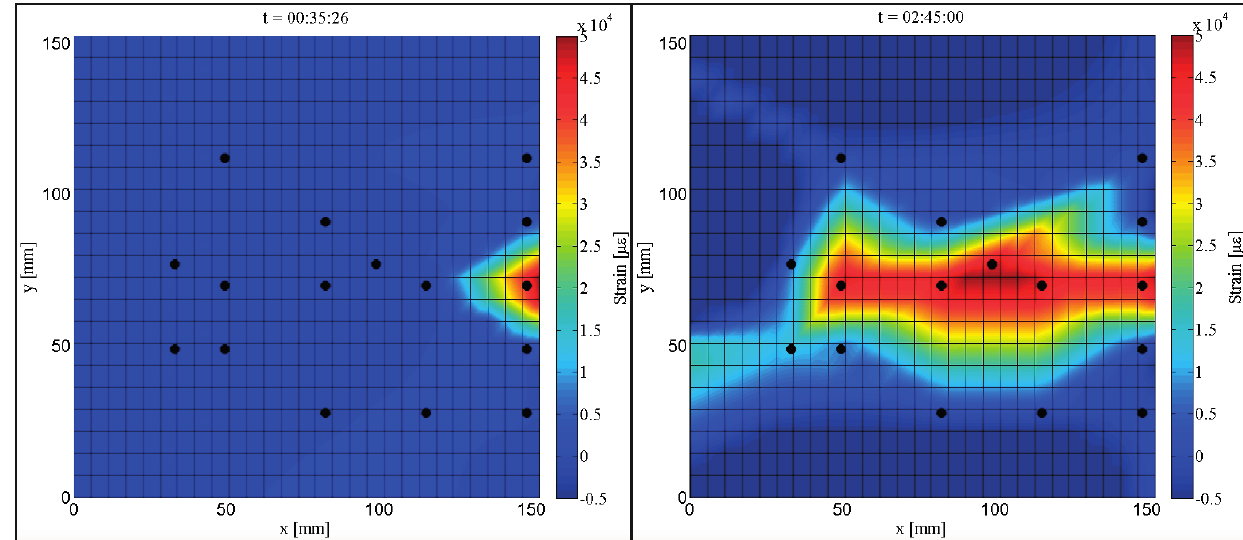
Figure 18. Maps of strain distributions in Plate #4 (Design 1); ( Left ): initialization of the crack (indicated in red color); ( Right ): crack extent at the end of the